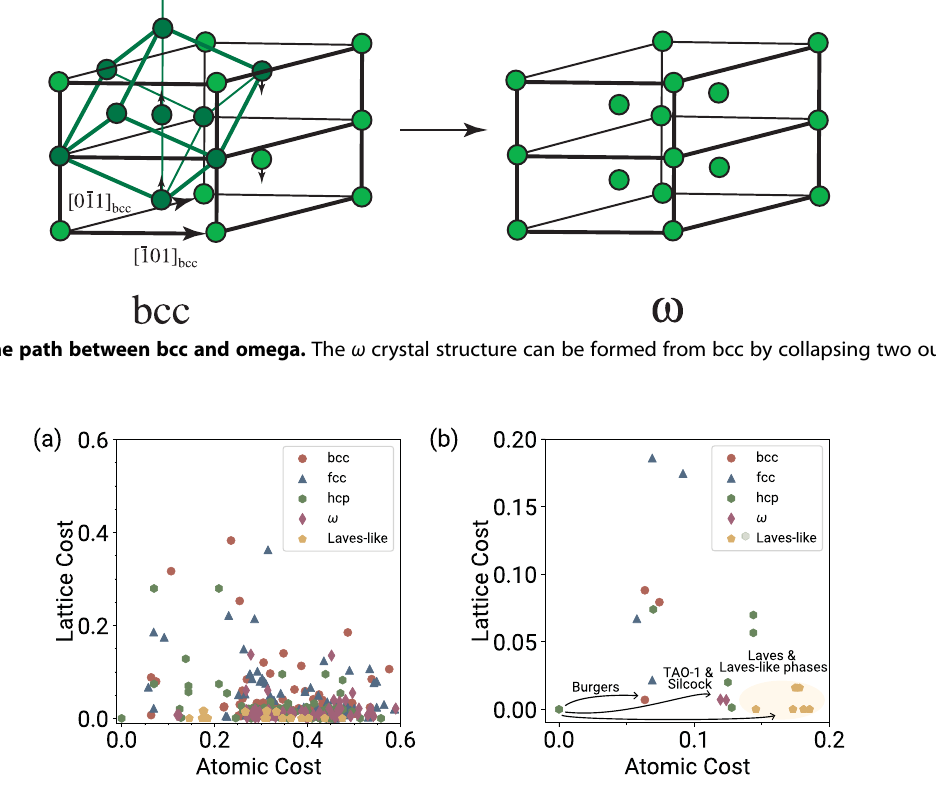
Fig. 8 Mapping costs of common structures onto hcp. Mapping costs of bcc, fcc, hcp, and ω onto a reference hcp crystal. a A large number of mappings have large atomic costs. b Several previously identi fi ed mappings 20,23,25 have much smaller mapping